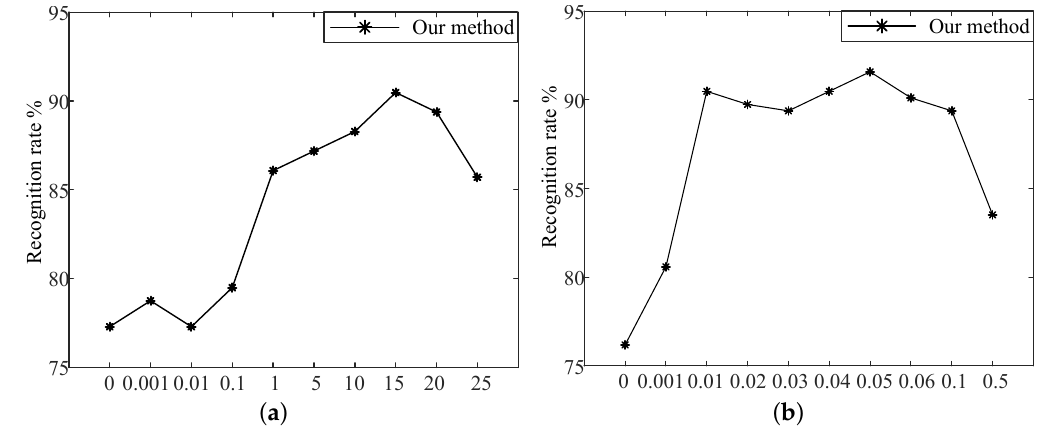
Figure 11. Parameter selection of λ 1 and λ 2 . ( a ) Parameter selection of λ 1 ; ( b ) Parameter selection of λ 2 .